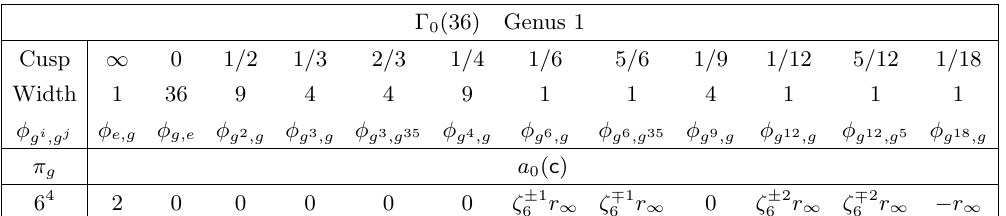
Table 2. Residues of the twining genera at all inequivalent cusps.